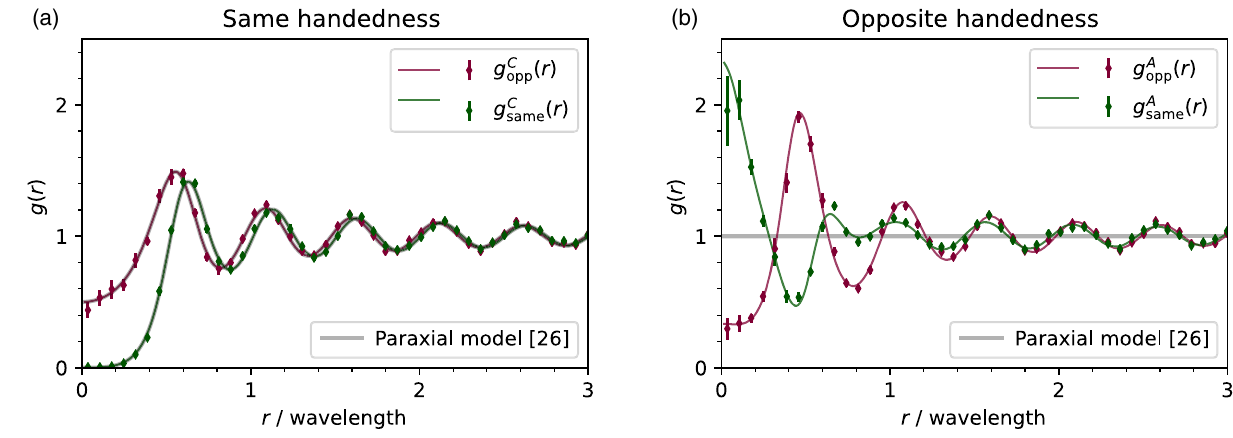
FIG. 6. Pair correlation function g ð r Þ for C points with the same (a) or opposite (b) handedness, and the same ( g topological index. Data points represent our experimental results, colored solid lines show our model for an isotropic 2D random field, and solid gray lines are the 3D paraxial model [26]. The solid gray lines in panel (a) overlap exactly with the colored solid